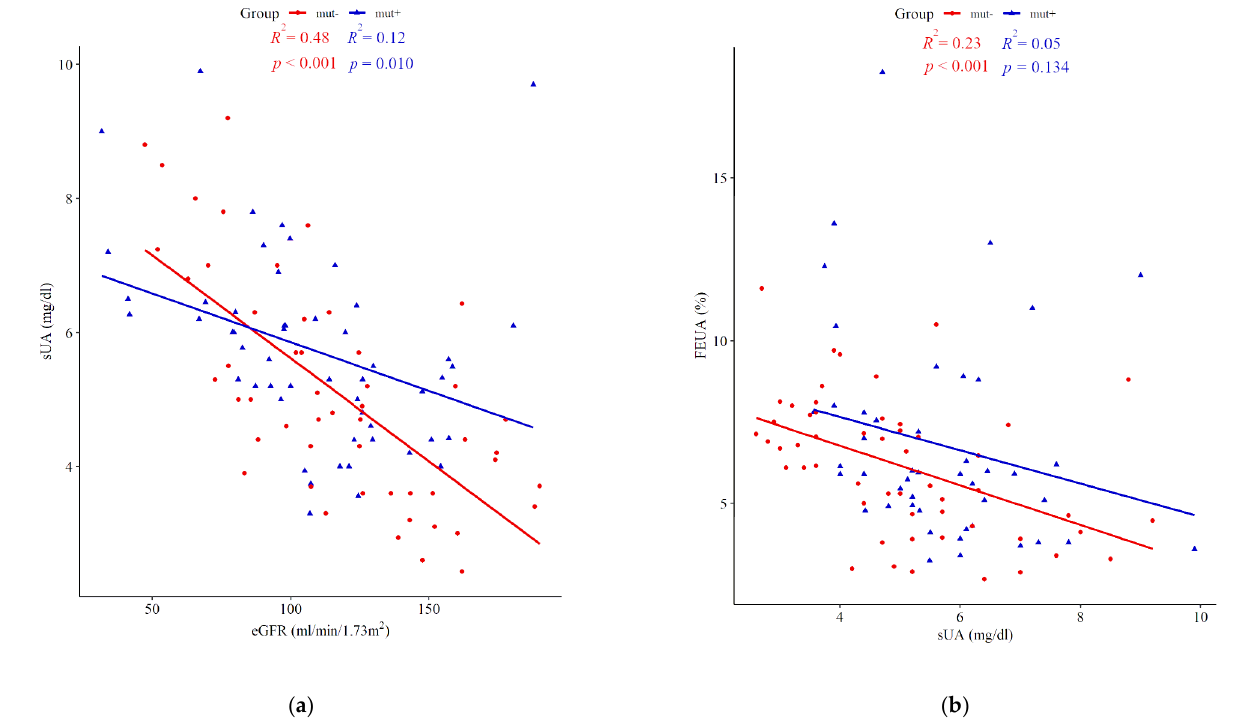
Figure 2. Correlations between serum uric acid (sUA) concentrations and estimated glomerular filtration rate (eGFR) ( a ) and fractional excretion of uric acid (FEUA) ( b ) in individuals with HNF1B mutations (mut+, blue triangles) and those who were negative for mutations (mut-, red dots). Table 3. Differences in serum uric acid levels, frequency of hyperuricemia and fractional excretion of uric acid between HNF1B positive and negative patients presented for age-specific intervals.